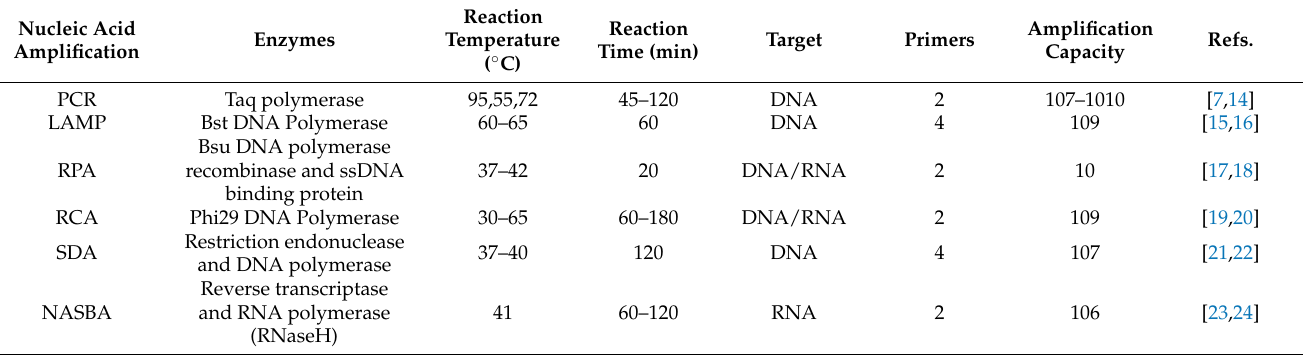
Table 1. Nucleic Acid Amplification